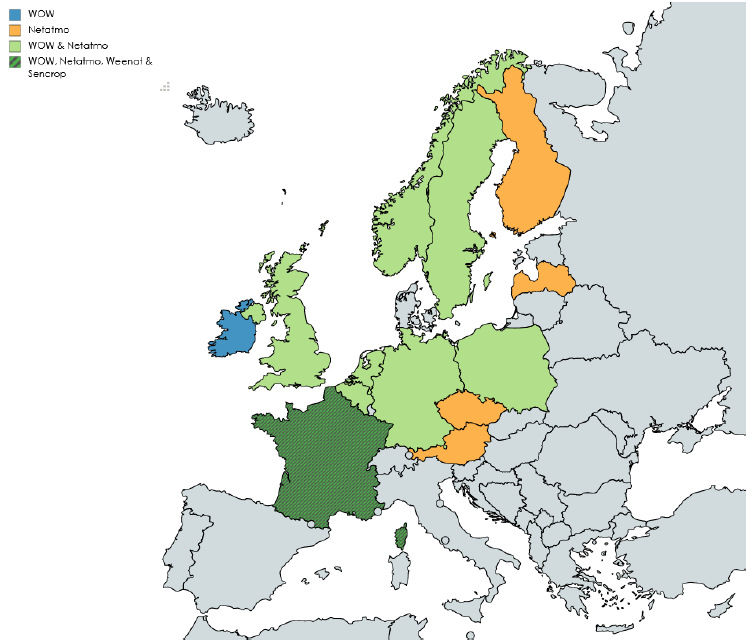
Figure 1. PWS activity (including Operational and Research) within the EUMETNET community by data providers. Data providers are active in more countries than highlighted here. data providers. Data providers are active in more countries than highlighted